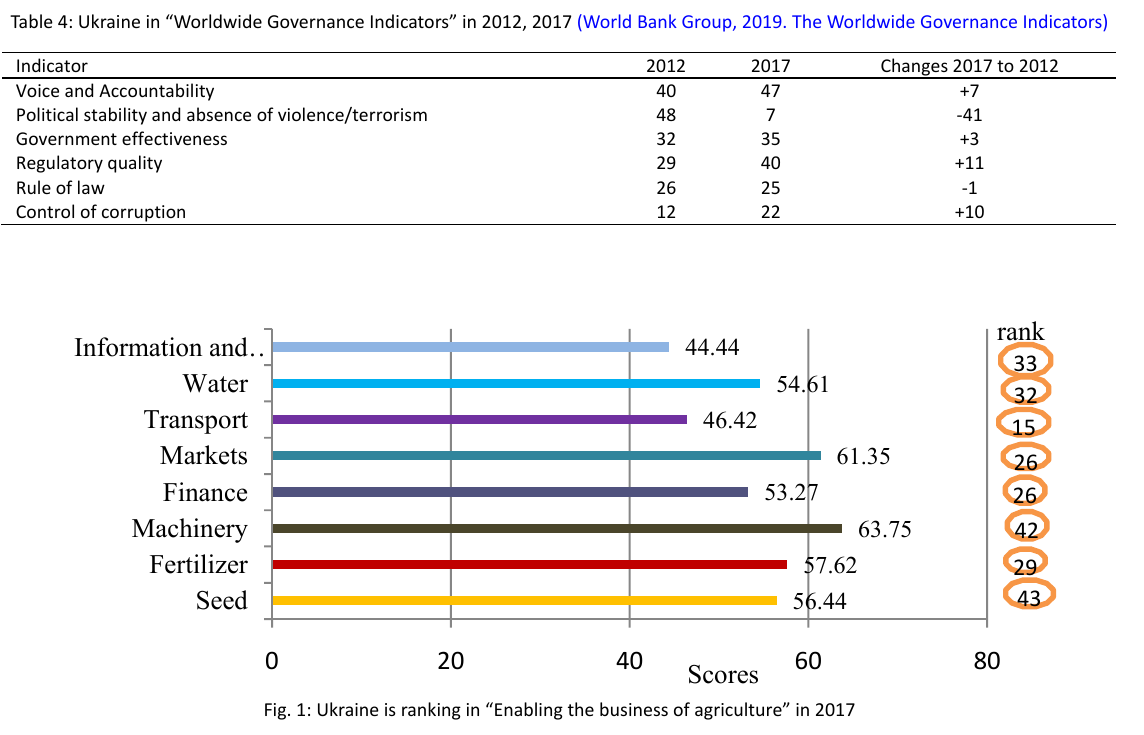
Fig. 1: Ukraine is ranking in "Enabling the business of agriculture" in 2017